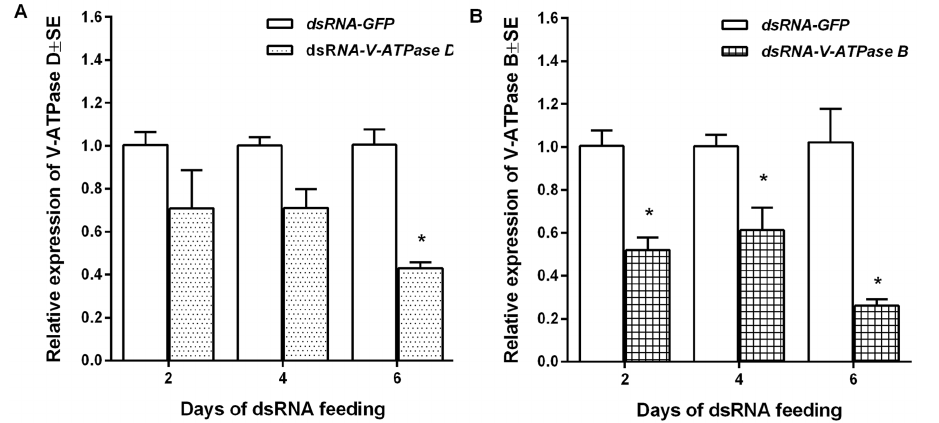
Figure 1. Reduction in the normalized abundance of V-ATPaseD and V-ATPaseB transcripts in Peregrinusmaidis by oral delivery of dsRNA. Third instar planthoppers were allowed to feed on dsRNA of V-ATPase D, dsRNA of V-ATPase B or dsRNA of GFP as a negative control treatment for up to six days. Insects were harvested two, four, and six days after feeding on dsRNA for real-time quantitative reverse transcriptase-PCR analysis of gene knockdown. The abundance of V-ATPase D ( A ) and V-ATPase B ( B ) transcripts was normalized to P. maidis ribosomal L10 transcripts. Each bar represents the mean and standard error of the mean of n = three experimental replicates each consisting of a group of three insects. The asterisk (*) indicates that treatment means differ significantly ( P , 0.05) at a given time-point.